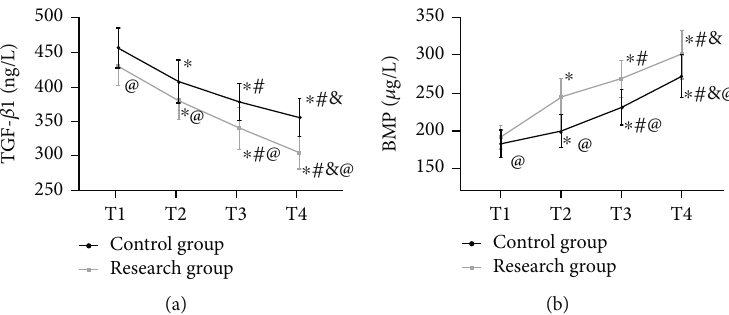
Figure 3: Comparison of growth factors. (a) TGF- β 1 during treatment. (b) BMP-7 during treatment. ∗ Di ff erence vs. the T1. # Di ff erence vs. the T2; & di ff erence vs. the T3; @ di ff erence vs. the control group. TGF- β 1: transforming growth factor-beta 1; BMP-7: bone morphogenetic protein-7.